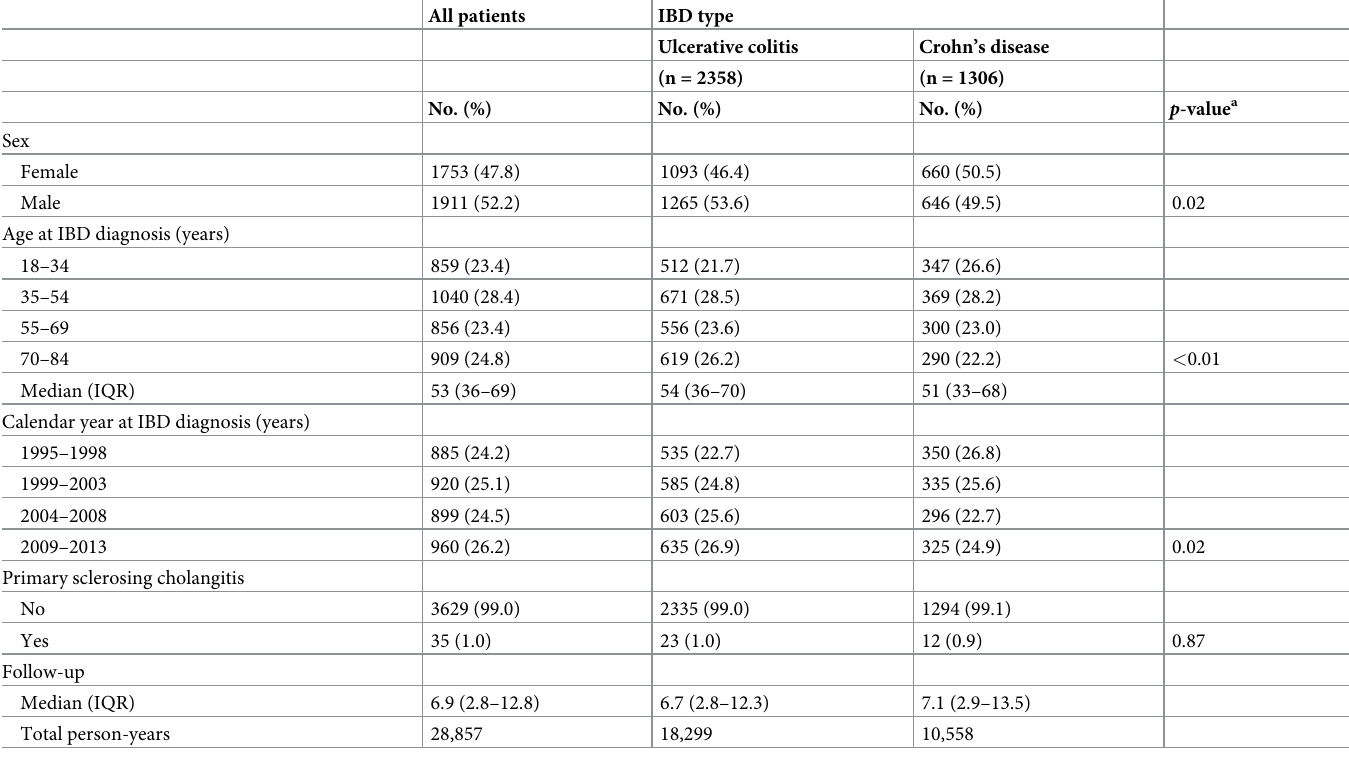
Table 1. Distribution of 3664 patients with Inflammatory Bowel Disease (IBD) by selected characteristics and IBD type. Friuli Venezia Giulia, northeastern Italy,